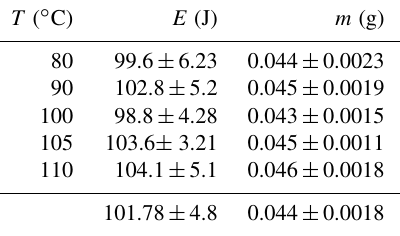
Table 3. Average and standard deviation mass ( m ) and energy loss ( E ) per droplet from the hotplate measured using the DEID for dif- ferent hotplate temperatures for 0.04g water droplets.